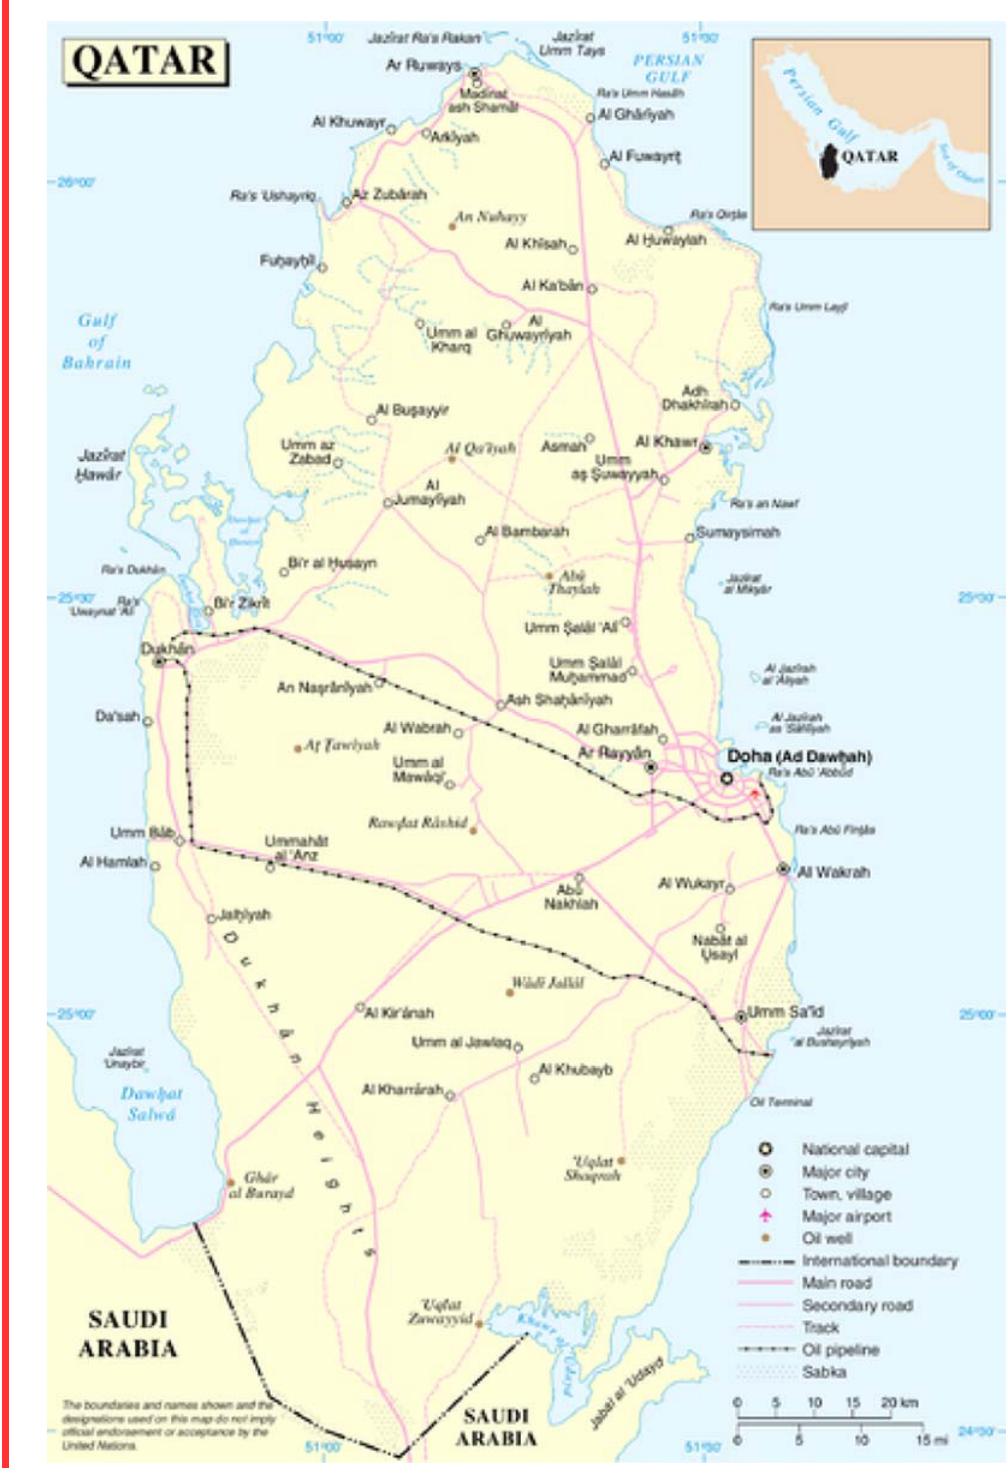
Figure 1. Map of